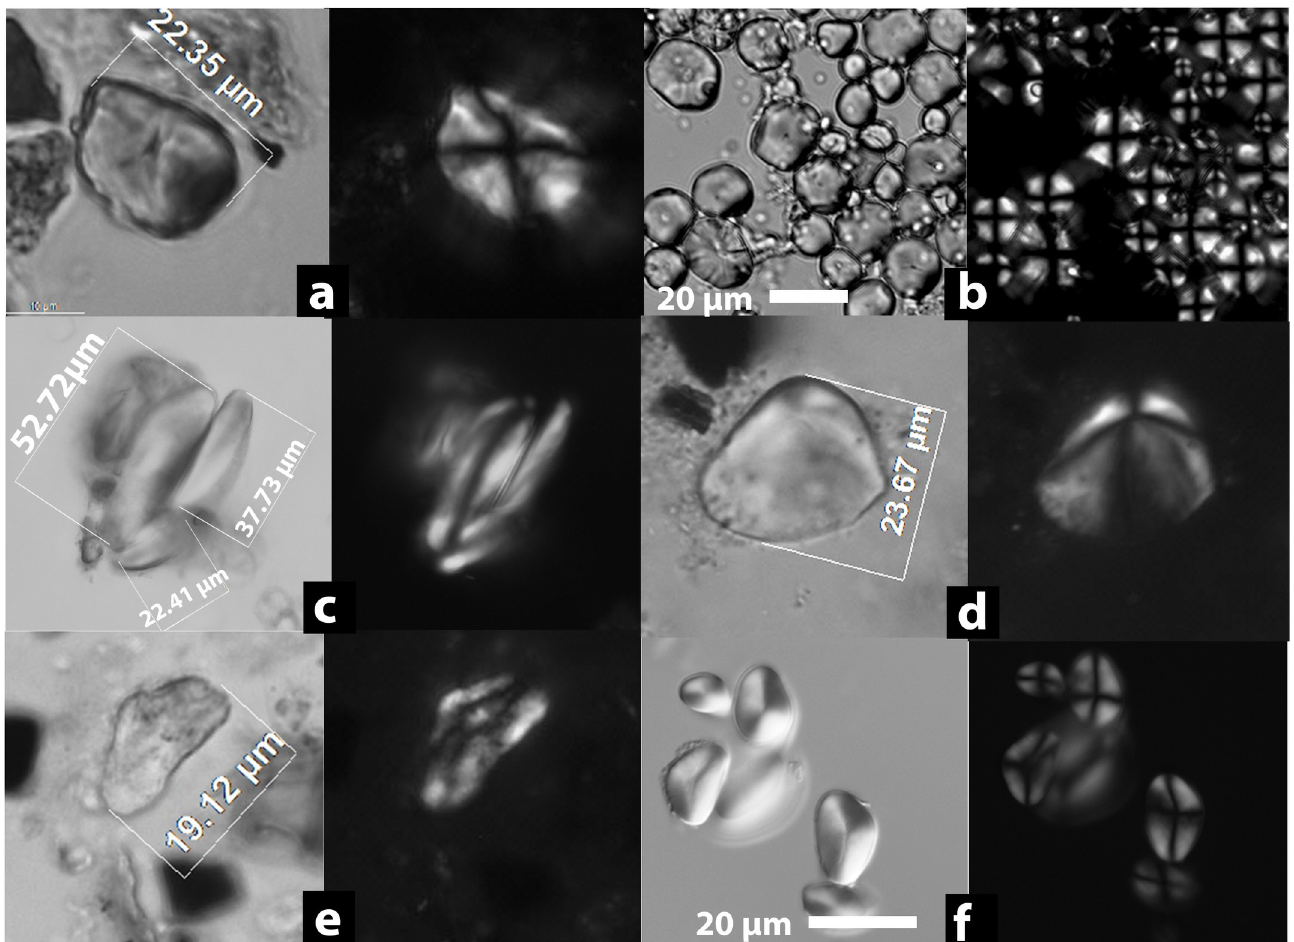
Fig 5. Starch remains from Qiaotou pottery compared with modern references. (a) Qiaotou Type II starch (Job’s tears); (b) Job’s tears ( Coix lacryma-jobi , from Yunnan); (c) and (d) Qiaotou Type III starch (Unidentified USOs); (e) Qiaotou Type IV starch (acorn); (f) Acorn ( Quercus fabri , from Zhejiang). Each starch granule/compound is shown in bright field and polarized